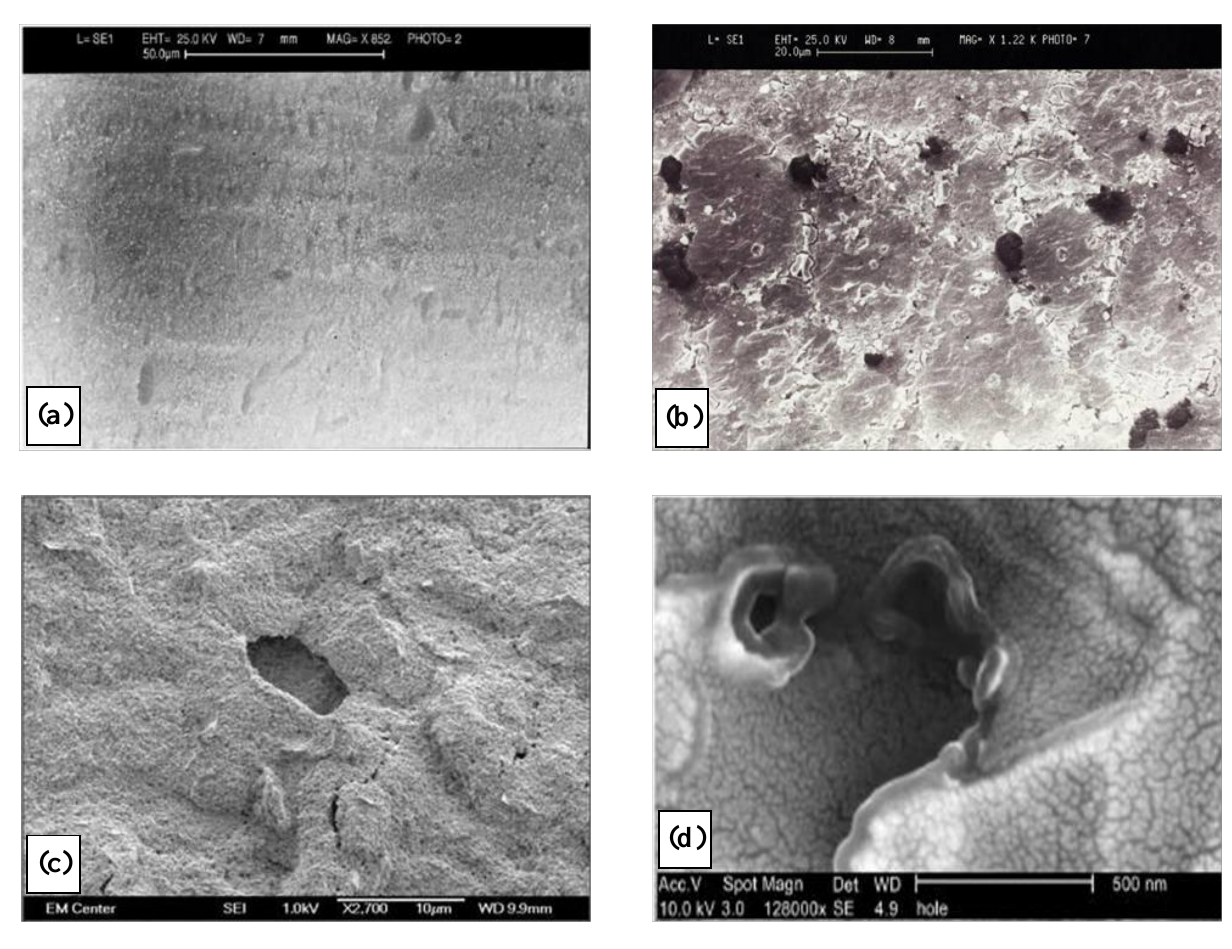
Figure 4. Deposition of poly(diaminobenzene) to form an insulating film. (a) Electron micrograph of insulated poly(diaminobenzene) insulated electrode surface. (b) Electron micrograph of sonochemically fabricated microelectrode array. (c) Close-up of sonochemically fabricated microelectrode array showing pore structure. (d)